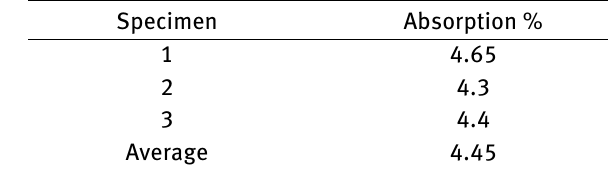
Table 23: Absorption of traditional mortar